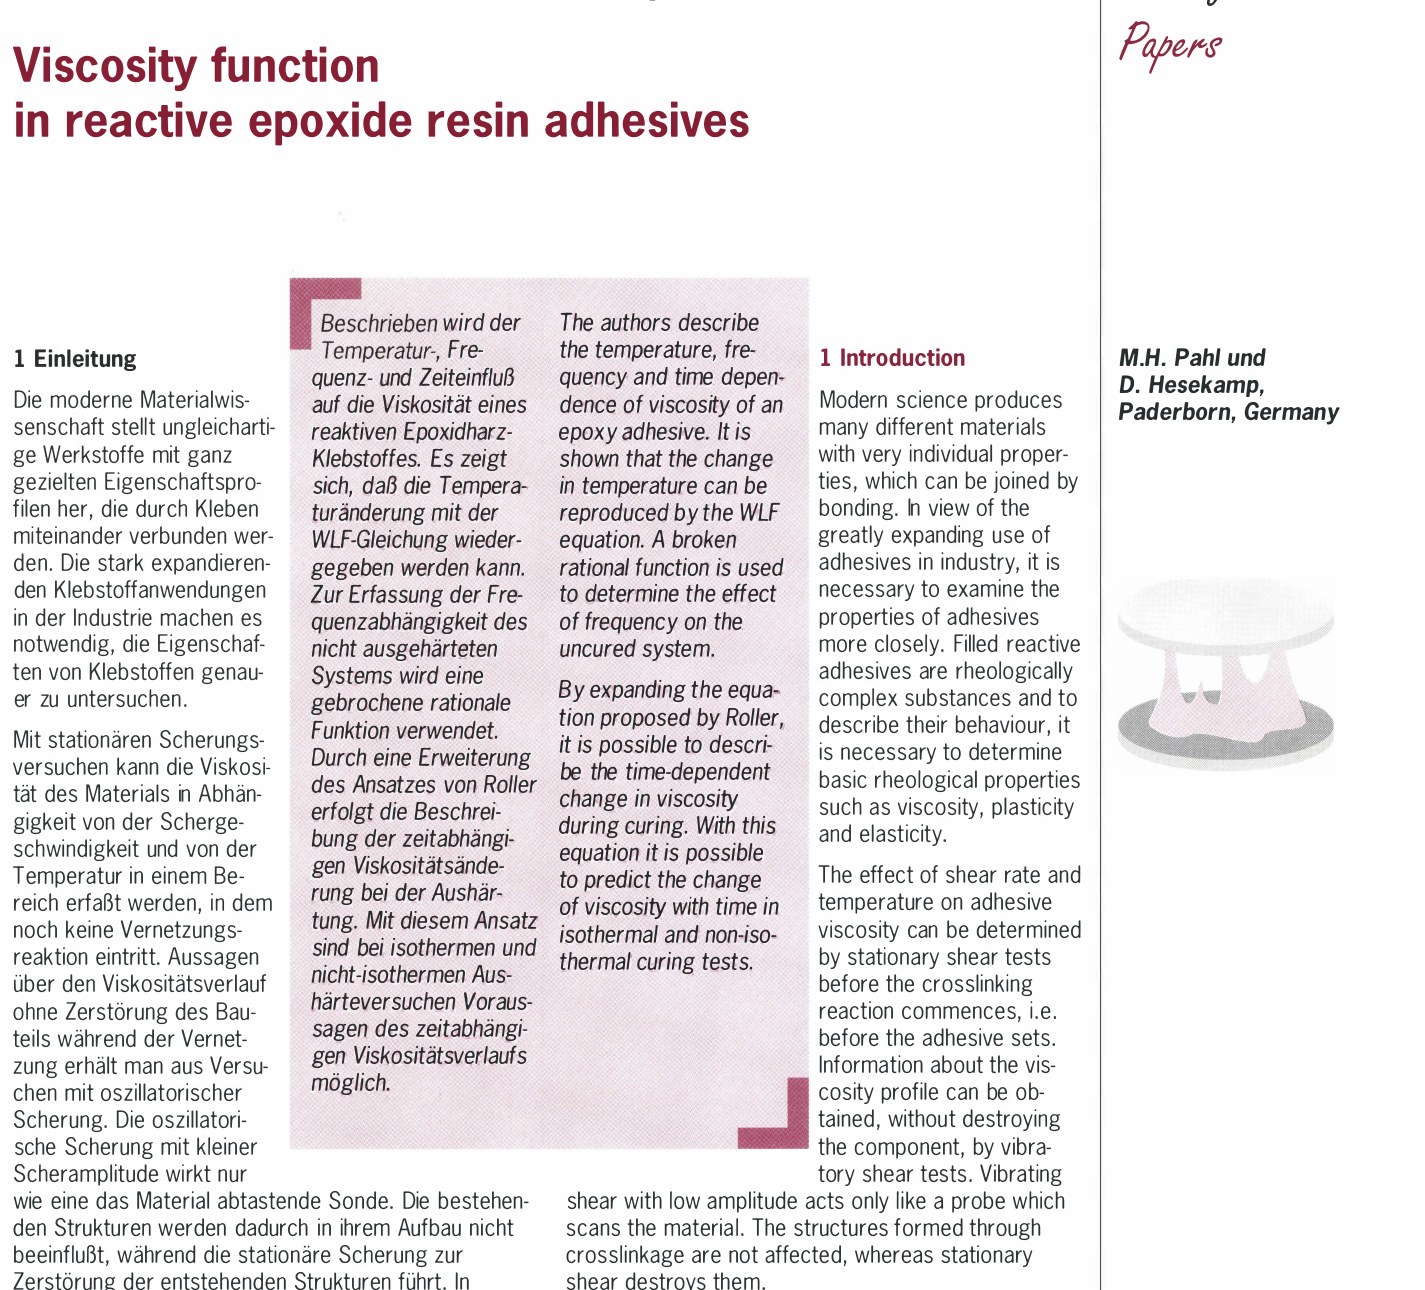
Fig. 1: Viscosity and temper­ ature profile during a non­ isothermal curing test on filled epoxy resin M